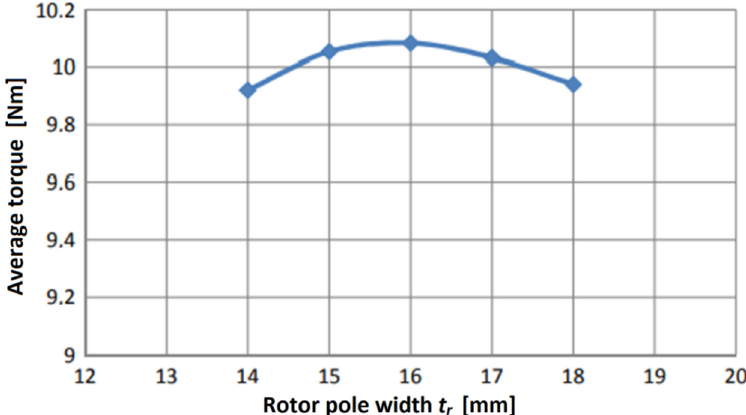
Figure 16. Characteristics of the average torque produced by the motor as a function of the rotor pole width t r , determined at I ph = 25 A.